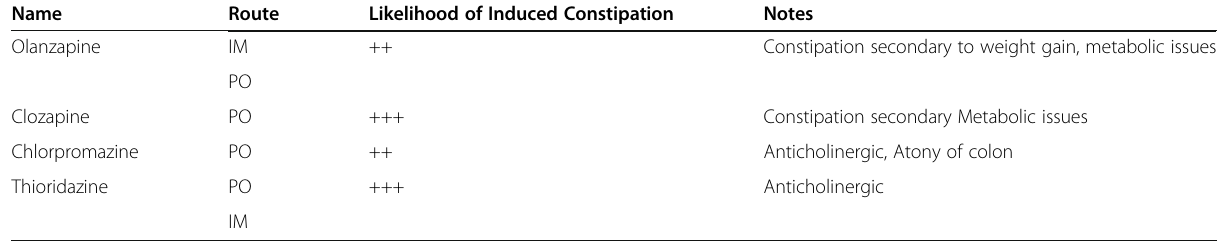
Table 1 Antipsychotic formulations and side-effect